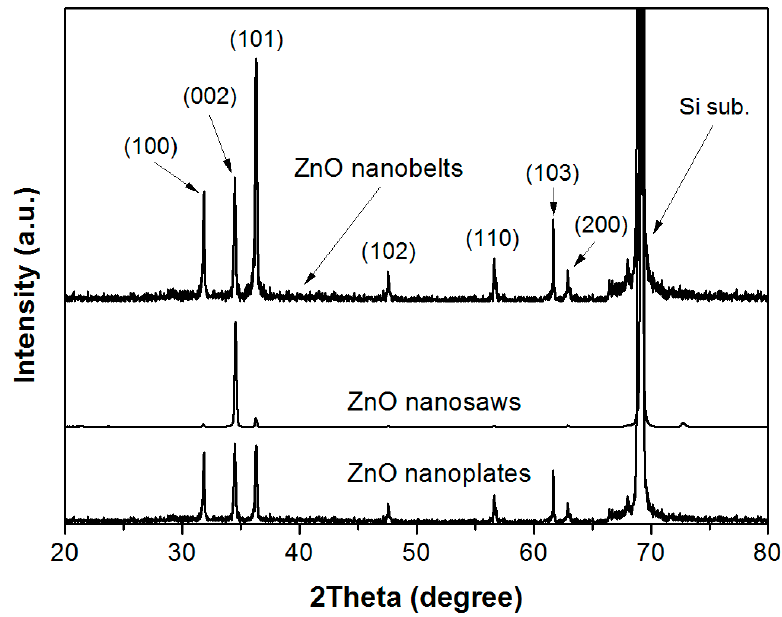
Figure 6. X-ray di ff raction (XRD) patterns of ZnO nanoplates, nanosaws, and nanobelts grown under Figure 6. X-ray diffraction ( XRD) patterns of ZnO nanoplates, nanosaws, and nanobelts grown under di ff erent experiment setups at growth temperature of 800 ◦ C and Ar / O 2 flow rate of 120 / 1.0 different experiment setups at growth temperature of 800 °C and Ar/O 2 flow rate of 120/1.0 sccm.